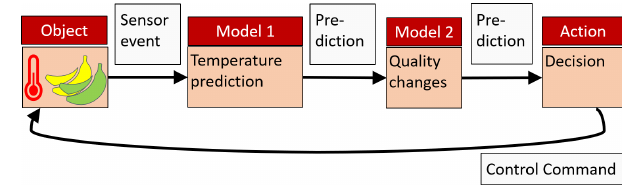
Figure 2. Example for linking different models inside a digital